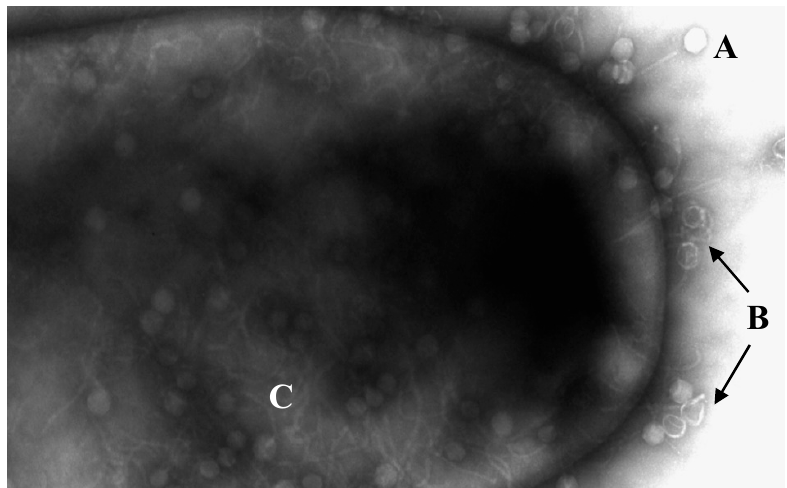
Figure 1. Electronic micrograph of C. difficile being infected by bacteriophages. ( A ) Phages without DNA injection. ( B ) Empty capsules by injection of DNA. ( C ) Viral replication inside the bacterium.